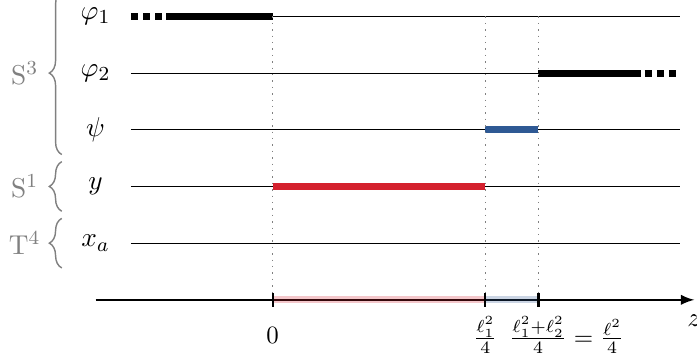
Figure 8 . Rod diagram of the shrinking directions on the z -axis after sourcing the solutions with two connected rods that force the degeneracy of y and ψ = k ( ϕ